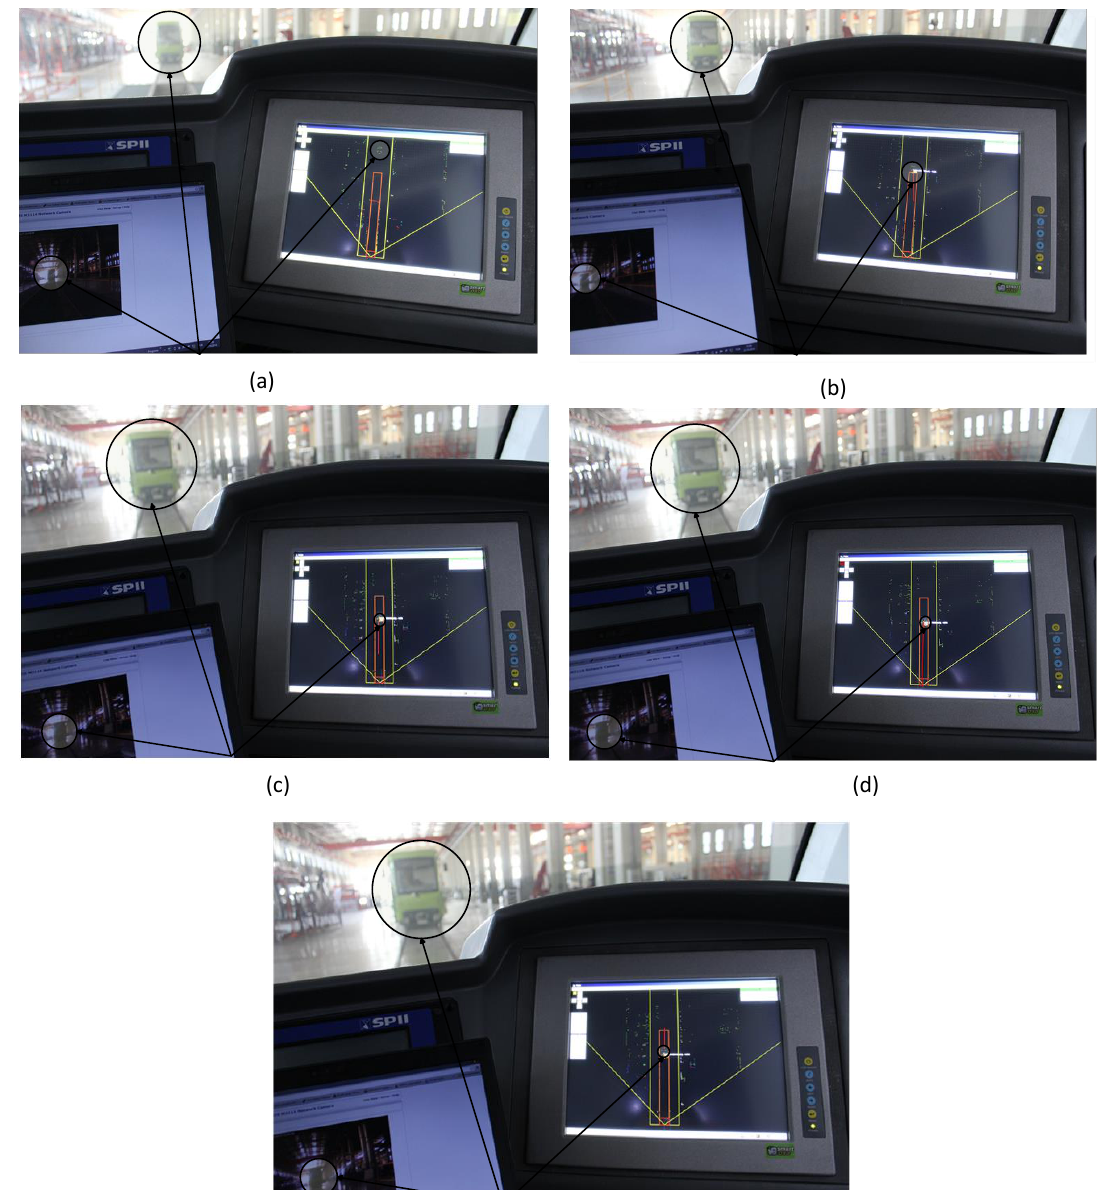
Figure 11. The scenarios of another LRV on the same line. ( a ) A static LRV on the same line with the test vehicle; ( b ) Another LRV on the same line approaching the test vehicle from the opposite direction with a velocity of 10 km/h; ( c ) Another LRV on the same line approaching the test vehicle from the opposite direction with a velocity of 10 km/h; ( d ) Another LRV approaching the test vehicle from the opposite direction with a velocity of 20 km/h; ( e ) Another LRV on the same line and with the same heading moving with a velocity of 20 km/h.